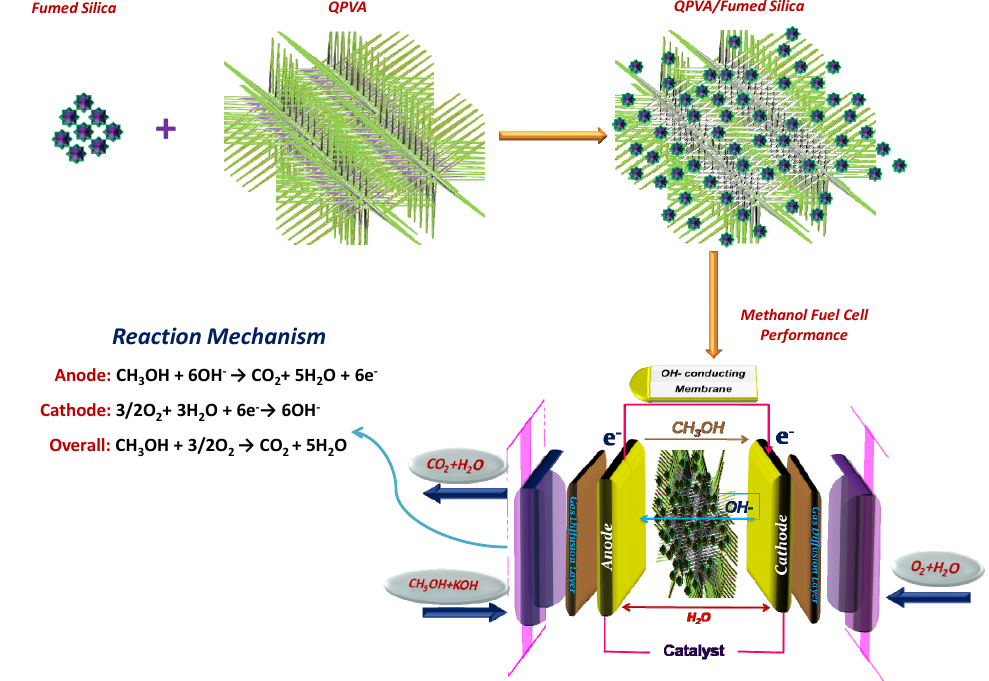
Figure 9. Schematic diagram for the formation of QPVA/fumed silica nanocomposite membranes and their effects on fuel cell performance for direct alcohol alkaline fuel cell applications.